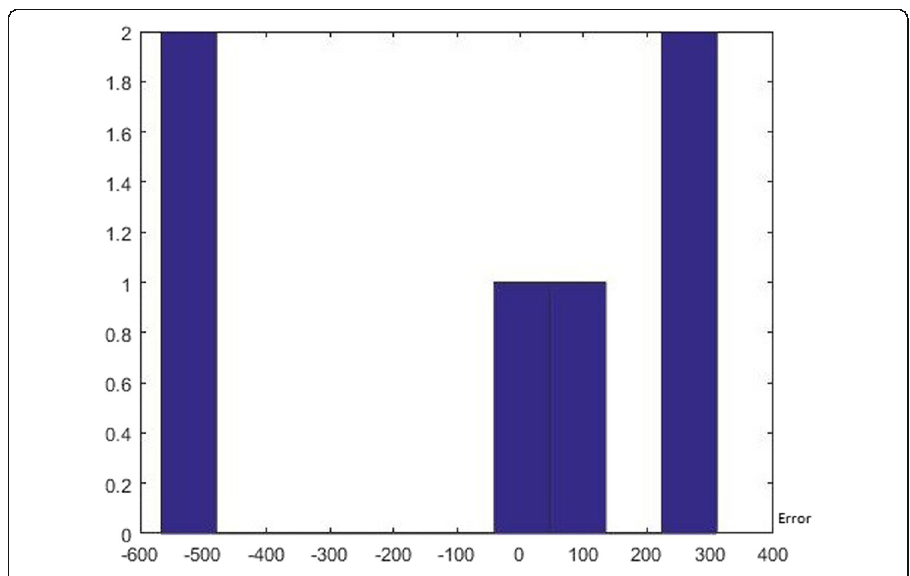
Fig. 2 Histogram of prediction errors in 5-days time window